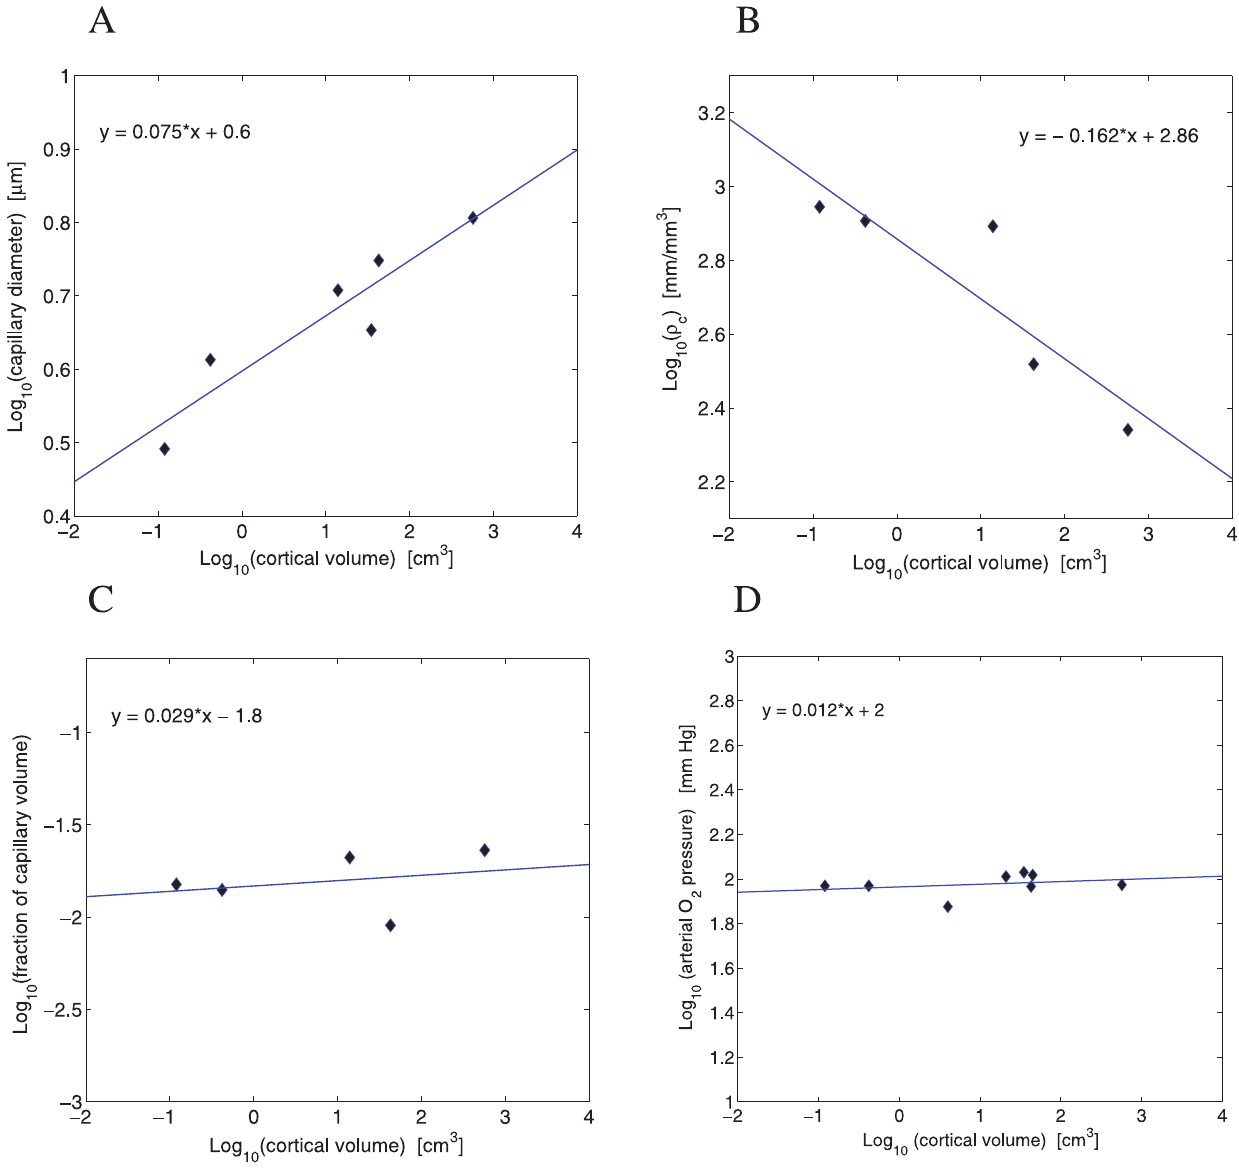
Figure 3. Scaling of brain capillary characteristics against brain size. (A) Capillary diameter scales against cortical gray matter volume with the exponent 0.075 ( y ~ 0 : 075 x z 0 : 60 , R 2 ~ 0 : 87 , p ~ 0 : 007 ), exponent CI=(0.034,0.117). (B) Volume density of capillary length r c scales with the exponent { 0 : 16 ( y ~{ 0 : 162 x z 2 : 86 , R 2 ~ 0 : 79 , p ~ 0 : 044 ), exponent CI=( 2 0.316, 2 0.008). (C) Fraction of capillary volume f c in gray matter is essentially independent of brain size ( y ~ 0 : 029 x { 1 : 83 , R 2 ~ 0 : 07 , p ~ 0 : 662 ), the same as (D) the arterial partial oxygen pressure ( y ~ 0 : 012 x z 1 : 96 , R 2 ~ 0 : 09 , p ~ 0 : 472 ). doi:10.1371/journal.pone.0026709.g003 Table 2. Because in general c v 0 , its presence in Eq. (8) reduces the power of R c . However, this effect is weak for medium and large brains as j c j % 1 . Even for a small rat brain the relative influence of c is rather weak, since j c j = 4 & 0 : 19 . In contrast, for very small brains, such as mouse, the effect caused by c is strong (Table 2), which reflects a sharp increase in the effective blood viscosity for the smallest capillaries [35,37].